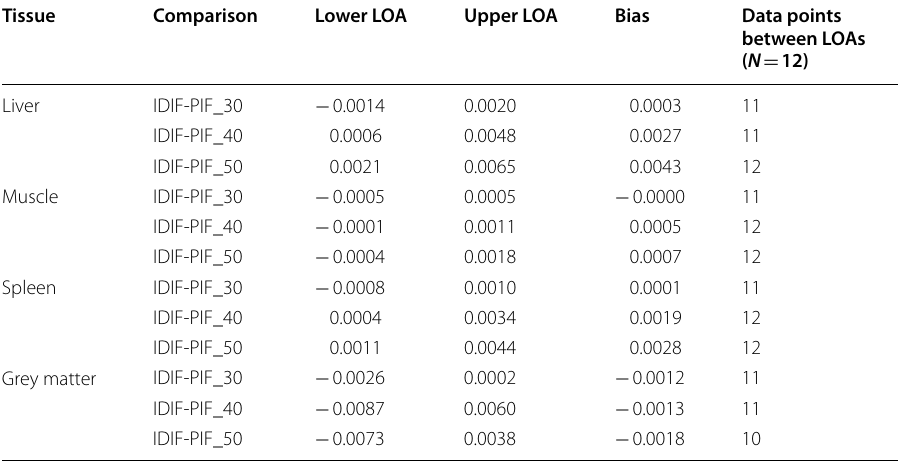
Bland–Altman analysis results i